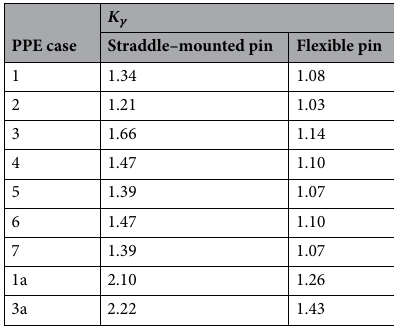
Table 5. K γ evaluated under the various PPE cases.